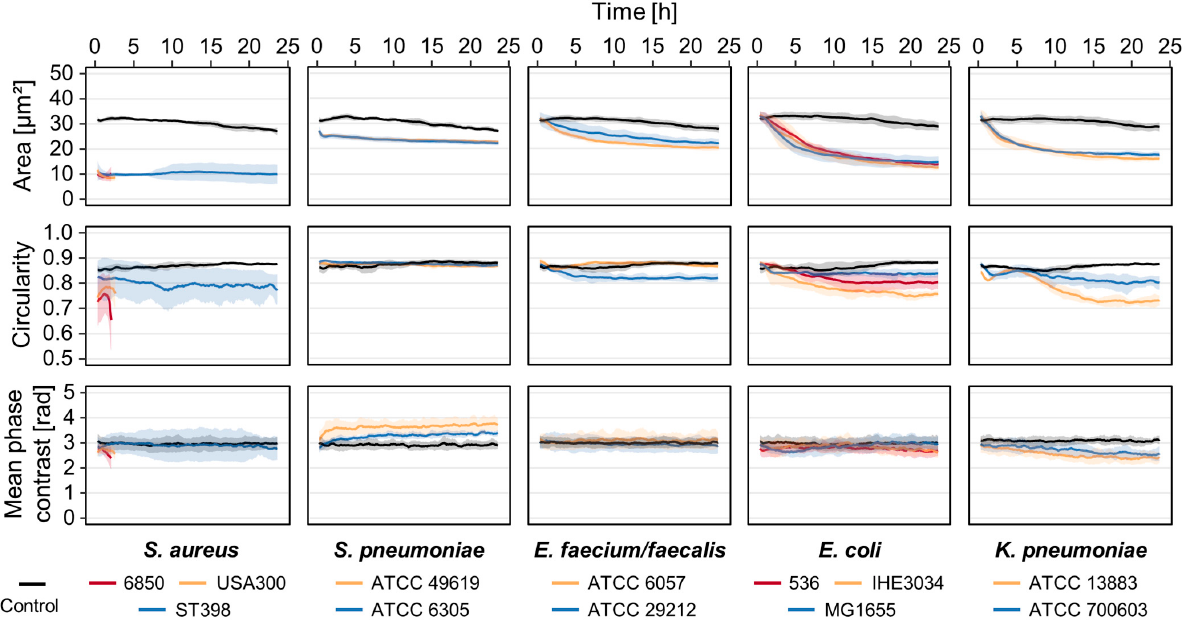
Figure 2. T-cell response to bacterial culture supernatant depends on both the species and strain. Human primary T-cells were exposed to sterile bacterial culture supernatants from various species and strains (colored lines) or left untreated as control (black lines). Timelapse DHM was applied to monitor the cellular response over time, and the resulting quantitative phase contrast images were analyzed for average single cell area, average circularity and mean phase contrast per cell. Results are presented as mean (solid lines) ± SD (shading) of at least three independent experiments. The curves were smoothed using moving averages with a window size of 15 measuring points.